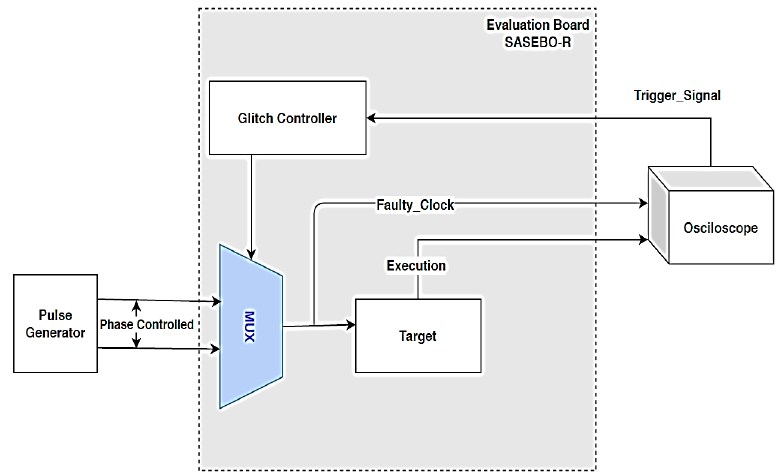
Figure 11. Experimental environment [41].